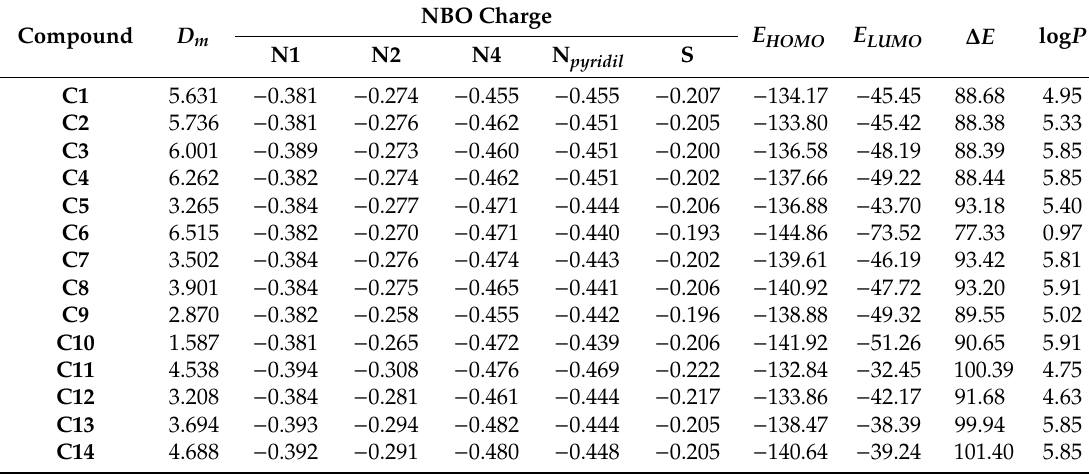
Table 2. The dipole moments, D m (D), NBO atomic charges, ( e ), energies of HOMO and LUMO orbitals, E HOMO and E LUMO (kcal / mol), ∆ E = E LUMO - E HOMO (kcal / mol) calculated for isolated molecules at DFT / B3LYP / 6-311 ++ G(d,p) level and calculated log P coe ffi cient for C1–C14. NBO Compound D m